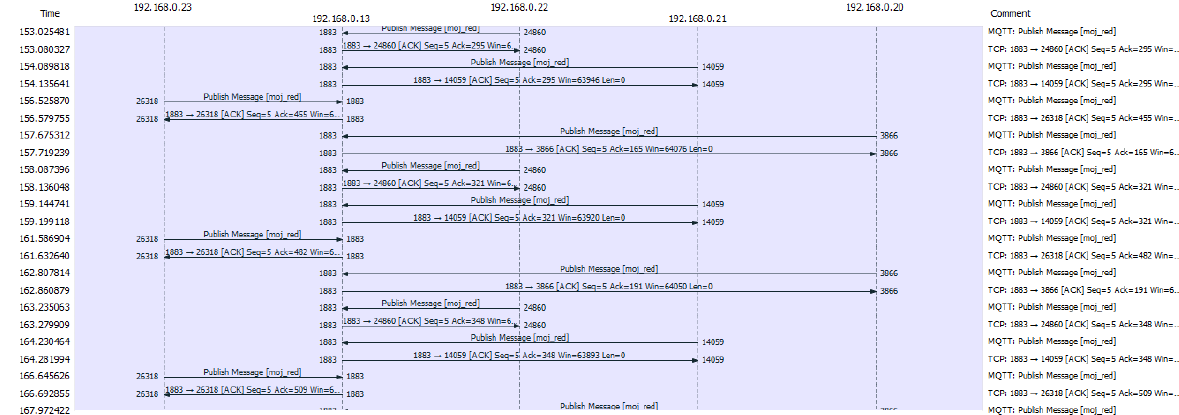
Figure 11. Communication flow between the server and four sensor nodes without error packets.